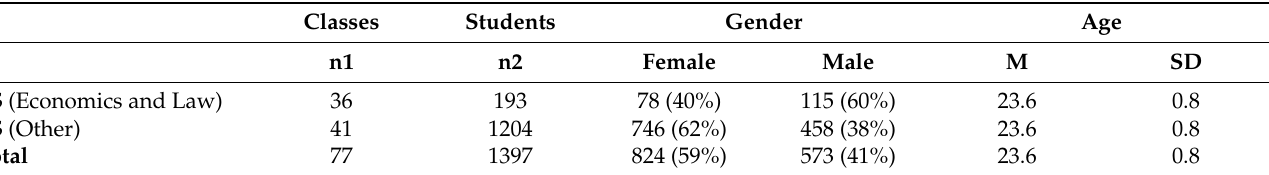
Table 2. Longitudinal sample (weighted).